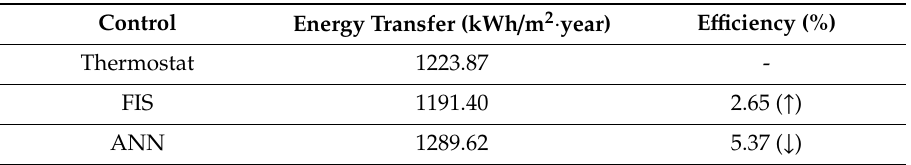
Table 3. Comparison of each energy